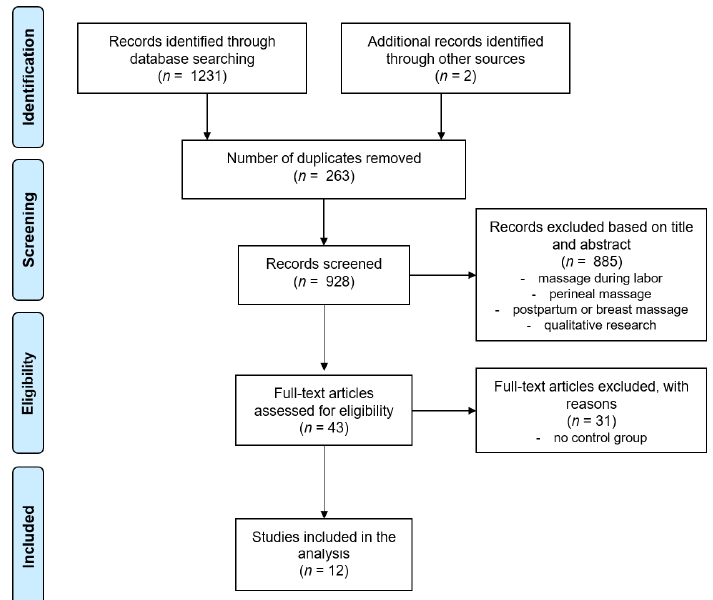
Figure 1. PRISMA flow chart of the searching and selection process.